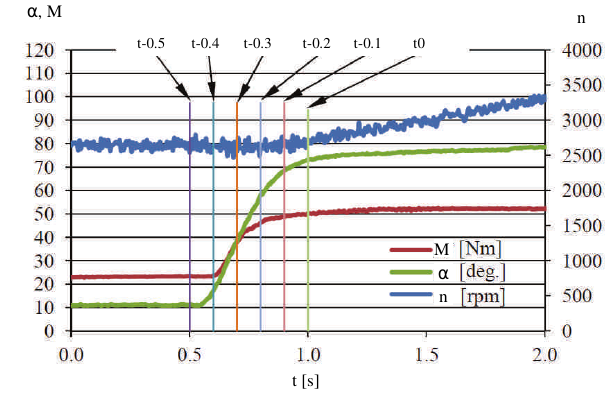
Fig. 4. Designation of time moments during engine operation Author considered 8 ANN configurations (Table 1).